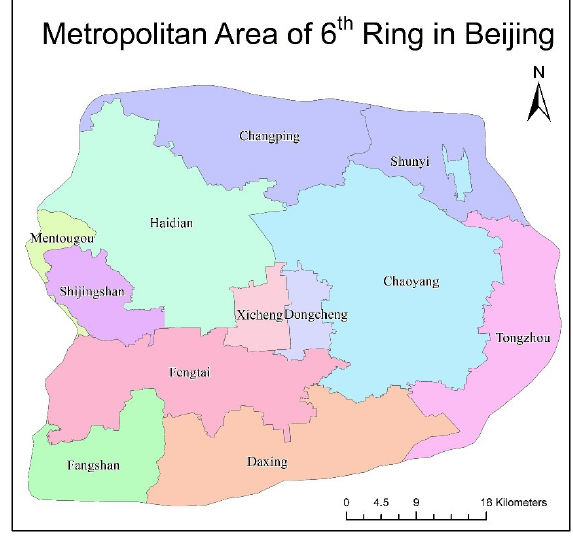
Fig. 1 Layout of Beijing Metropolitan